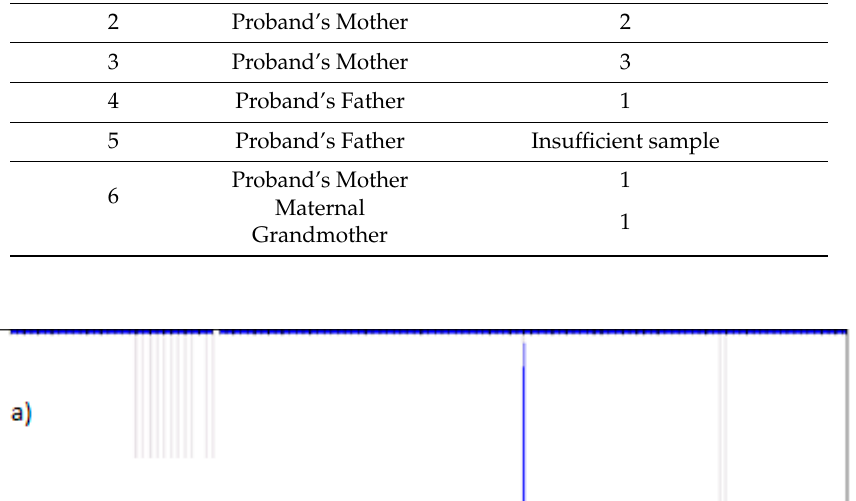
Table 4. Family studies—AGG interrupt data.